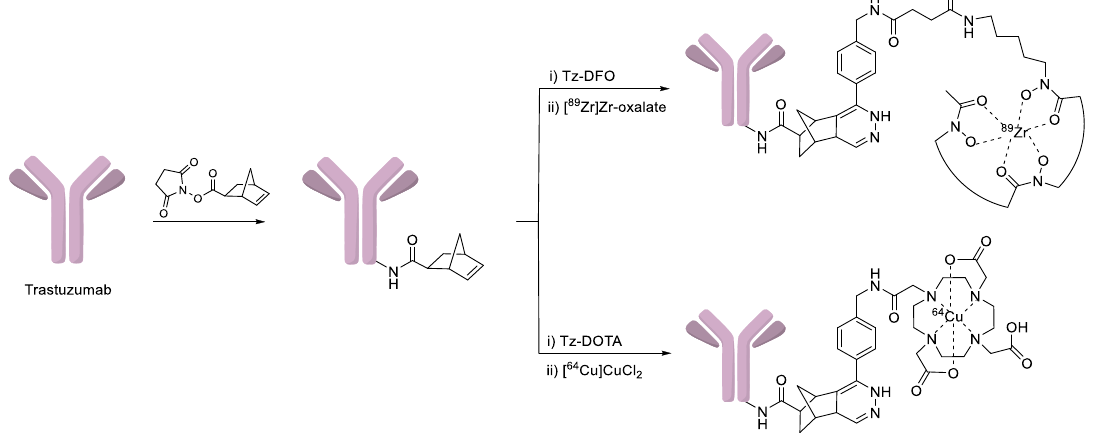
Figure 10. IEDDA-mediated radiolabeling of trastuzumab.